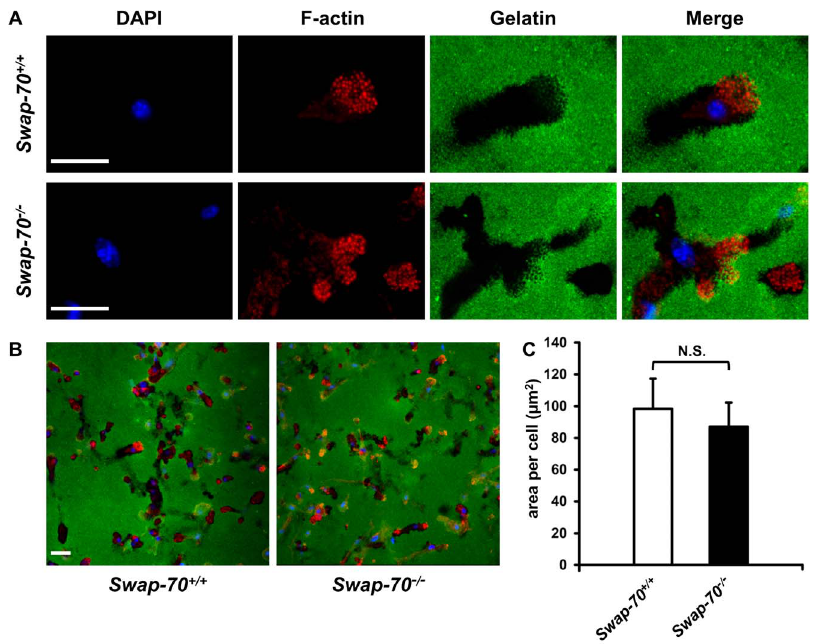
Figure 4. Podosome-mediated degradation of gelatin is not affected by SWAP-70 deficiency in DCs. ( A-B ) Confocal immunofluorescence microscopy analysis of gelatin degradation by Swap-70 + / + and Swap-70 –/– DCs. DCs were seeded on Oregon Green-labeled gelatin (green) and incubated for 4 h. Cells were stained with rhodamine phalloidin for F-actin (red) and DAPI for the nucleus (blue). Representative detailed ( A ) and overview ( B ) pictures are shown. ( C ) Quantification of the area (in m m 2 ) of Oregon Green-labeled gelatin degraded by DCs. Mean values of 3 independent experiments with error bars indicating + SD are shown (300-500 cells were analyzed per genotype and experiment). N.S. denotes not